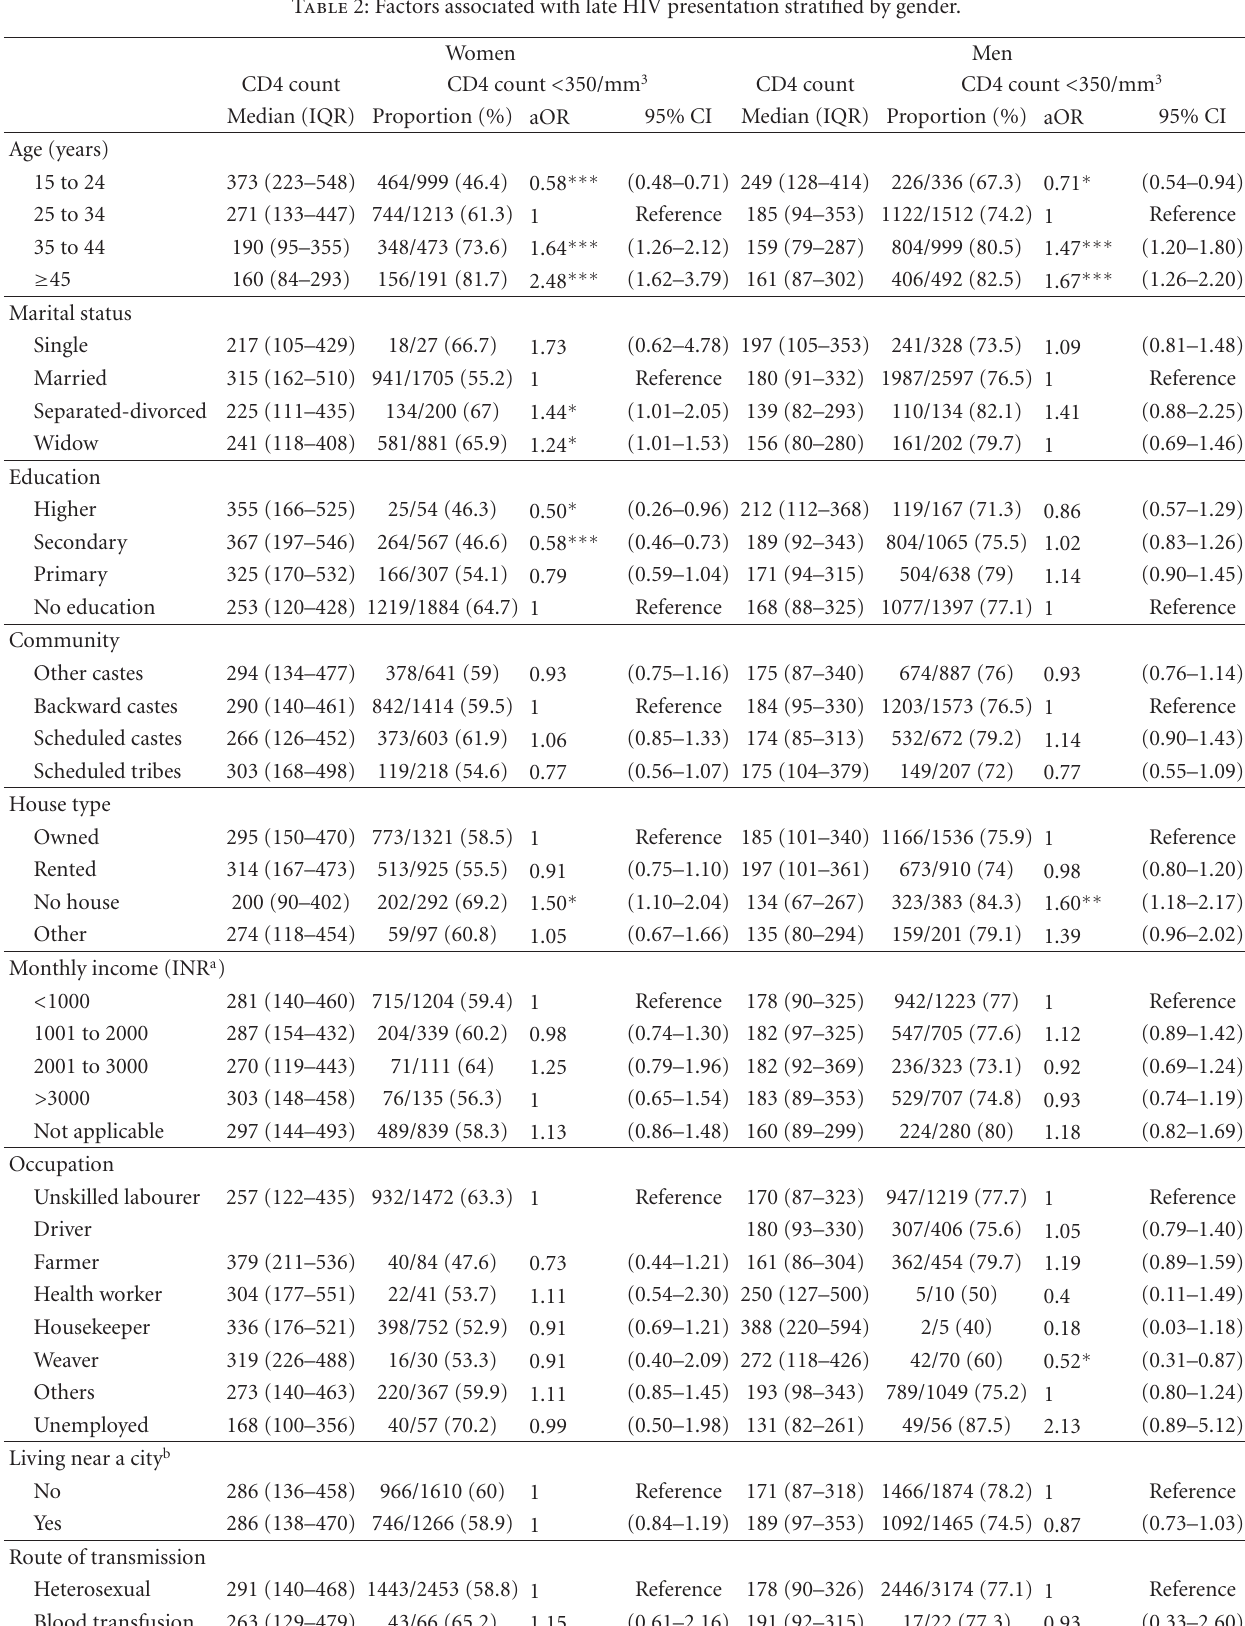
Table 2: Factors associated with late HIV presentation stratified by